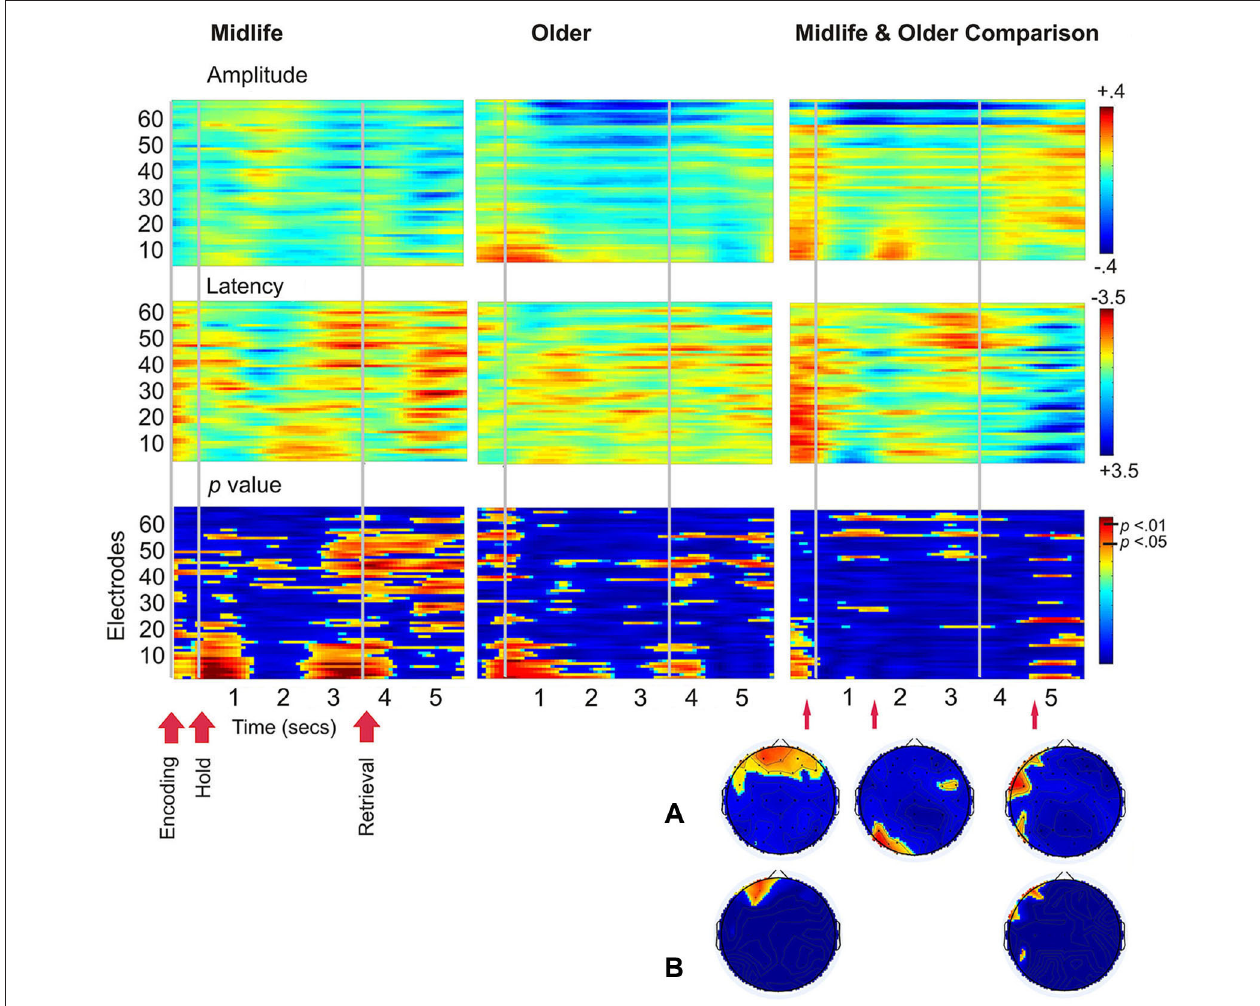
Hotelling’s T p -value plot below indicates the between groups statistical effects for the working memory task in the older group compared to the midlife group. (A) Topographical maps display maximal statistical effect for the older group compared to the midlife group. (B) Topographical maps display maximal statistical effect for a subset of the older group compared to a subset of the midlife group, when the sample is split into tertiles to compare the oldest (67–82 years) to the youngest (40–56)